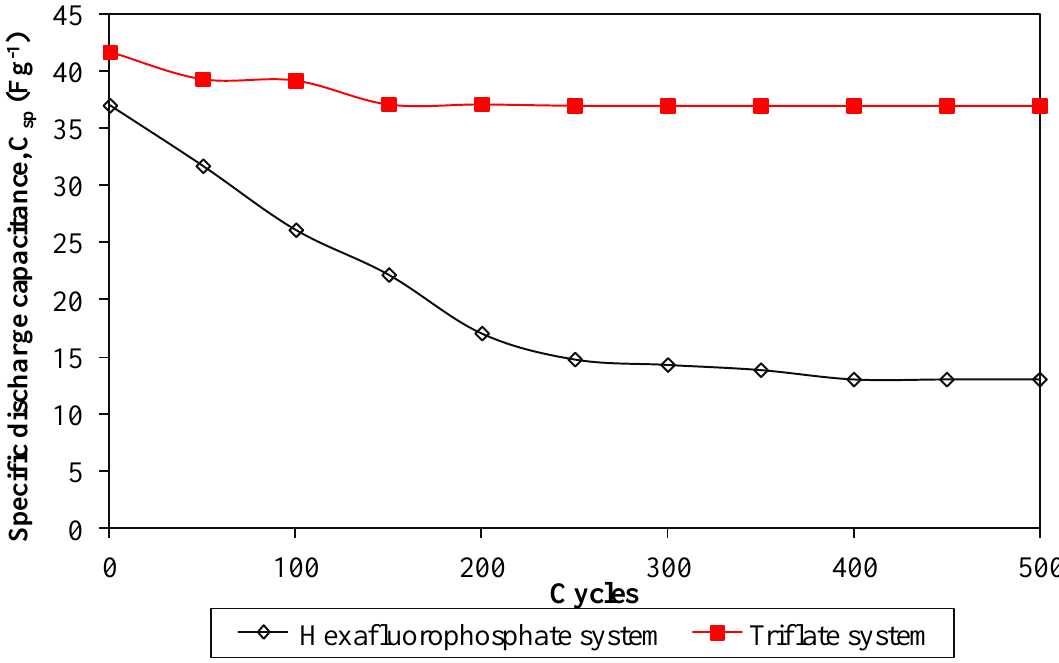
Figure 8. Specific capacitance of different ionic liquid-based biopolymer electrolyte systems over 500 cycles.